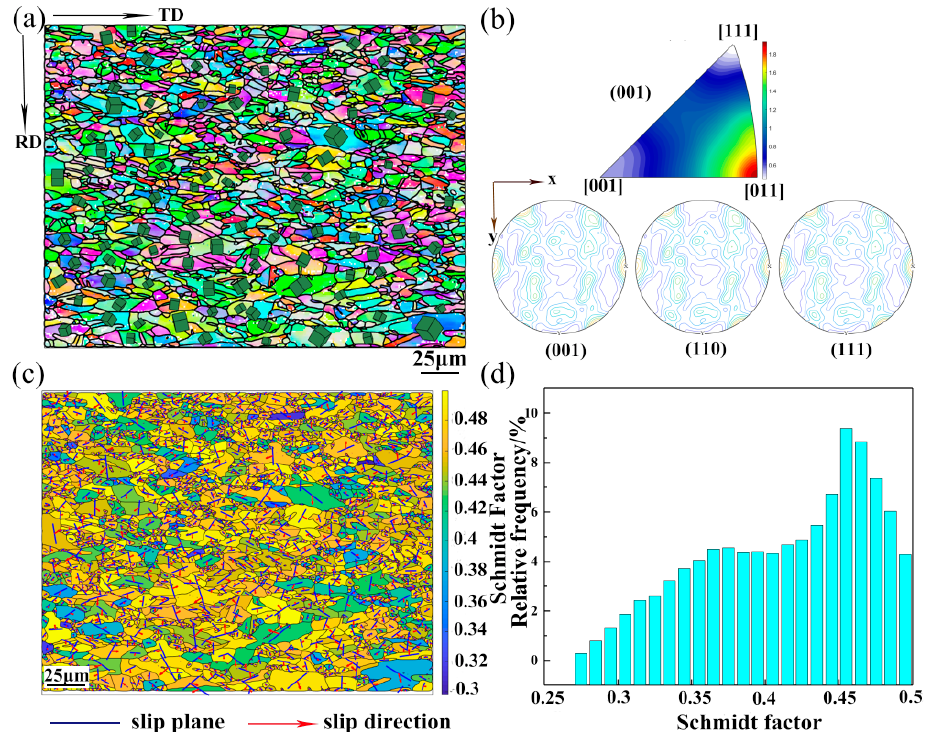
Figure 2. ( a ) EBSD IPF image of the UT specimen with the crystal orientations of the big grains (the average grain size is about 20 μ m) shown by the crystal shape orientated according to the orientation of the grains; ( b ) Grain orientation of each grain in the (001) plane and (001), (110), (111) pole figures of ( a ); ( c ) Schmidt factors calculated by the slip systems as well as stress tensor in the crystal coordinates; and ( d ) Schmidt factor distributions (histogram) of the UT specimen.